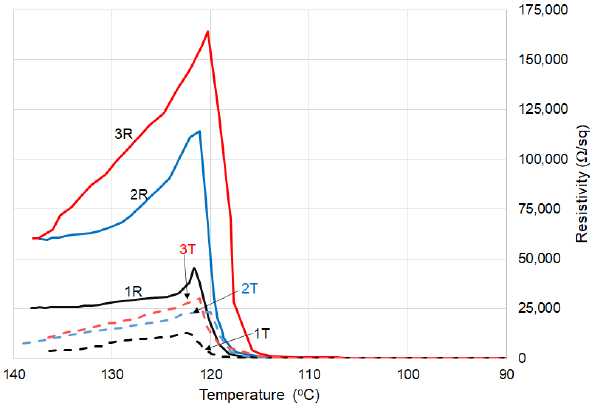
Figure 12. Resistivity vs. temperature for (CB + Gr)/(LLD + HD) samples on repeated temperature cycles, cooling portions: 1T, 2T, 3T — thermoplastic (D = 0 kGy) cycles 1, 2, 3, respectively; 1R, 2R, 3R — crosslinked (D = 150 kGy), cycles 1, 2 and 3, respectively.